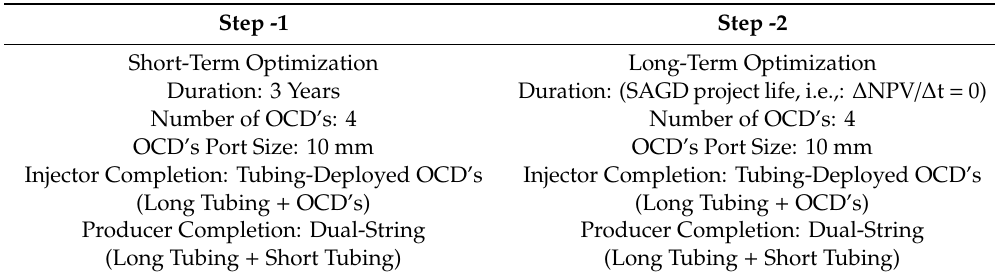
Table 2. OCD’s optimization steps.